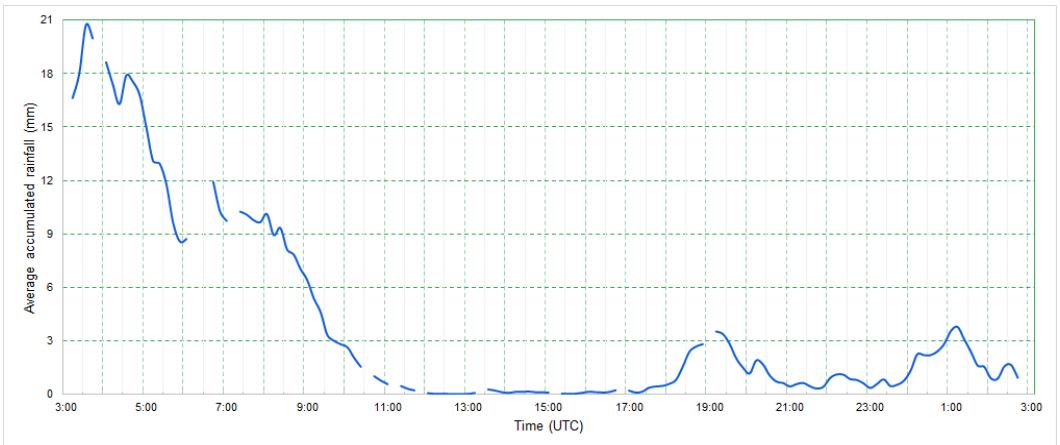
Figure 7. Time series of 10-min accumulated rainfall over São Paulo for 11 March 2016 based on observations from the SPOL weather radar.